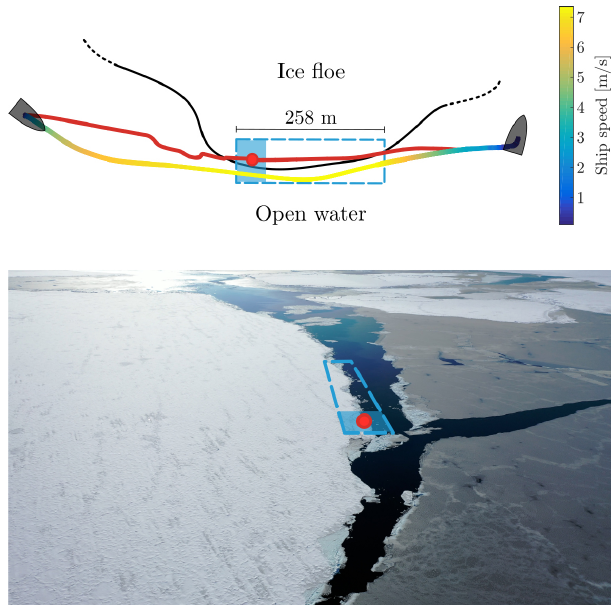
Figure 1. Schematic representation of the experiment conducted in the GSL. The grey shape represents the ship, and the red and blue-to-yellow lines are the UAV and ship GPS tracks, respectively. The red dot is the fixed position from which the drone filmed the breakup, and the filled blue rectangle is its field of view. The dashed blue rectangle is the area covered by the panoramic picture obtained by taking multiple pictures of the resulting broken ice (Fig. 7). The black line shows the approximate location of the floe edge. The bot- tom image is an overview of the selected floe and surrounding ice conditions.